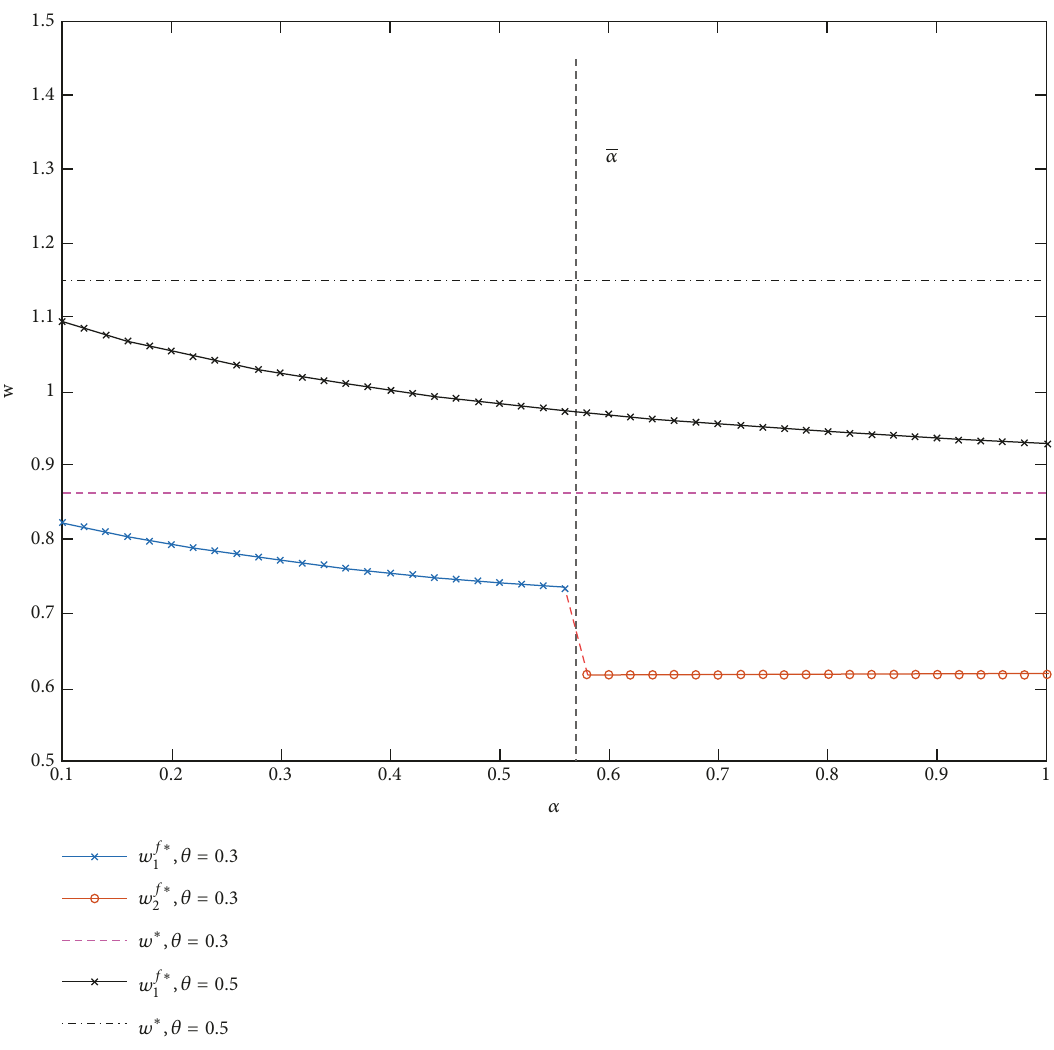
Figure 4: Impact of 𝜃 and 𝛼 on 𝑤